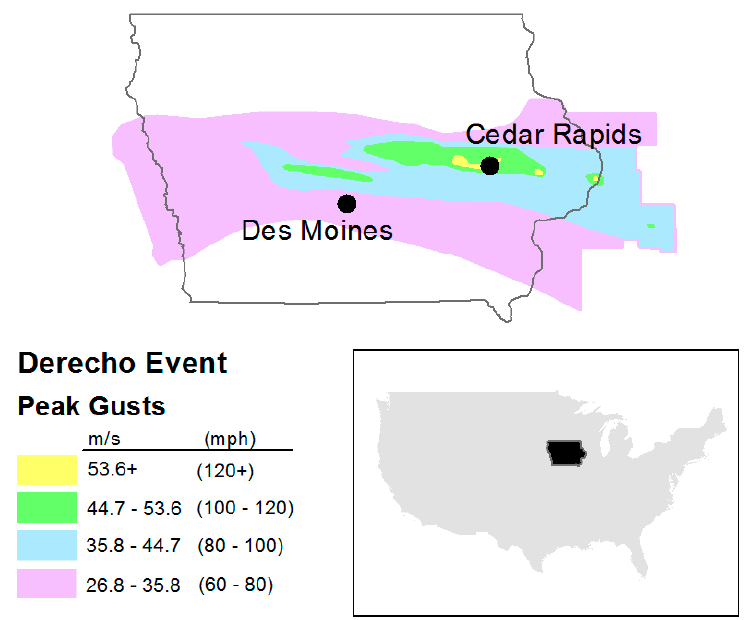
Figure 1. Estimated peak wind gusts of the Midwest Derecho, 10–11 August 2020, Iowa, USA. Data source: NOAA Storm Prediction Center.